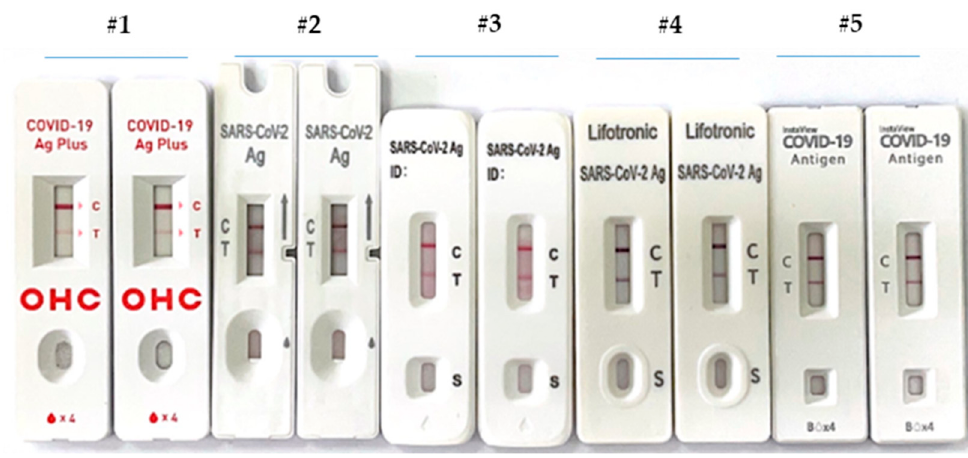
Figure 3. The capabilities of five different test systems, RATs, to recognize Omicron BA.4 from the same sample.